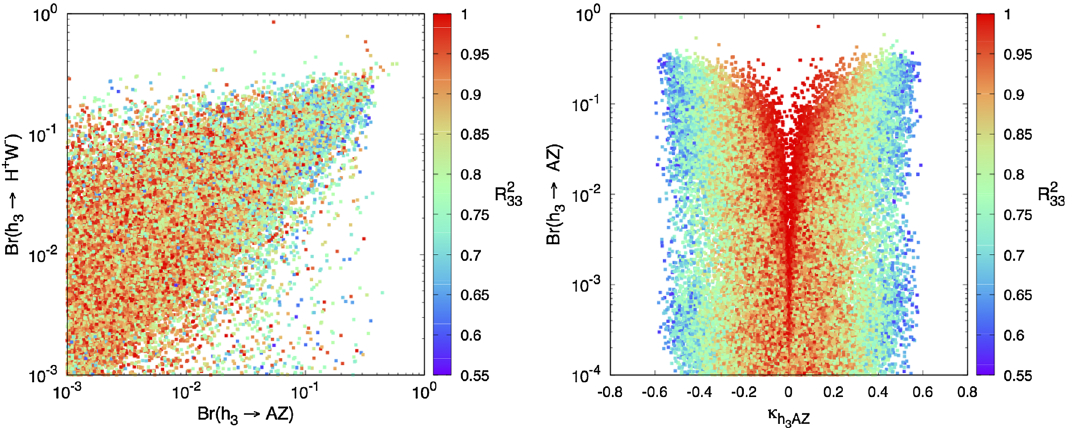
and R 2 33 3 AZ